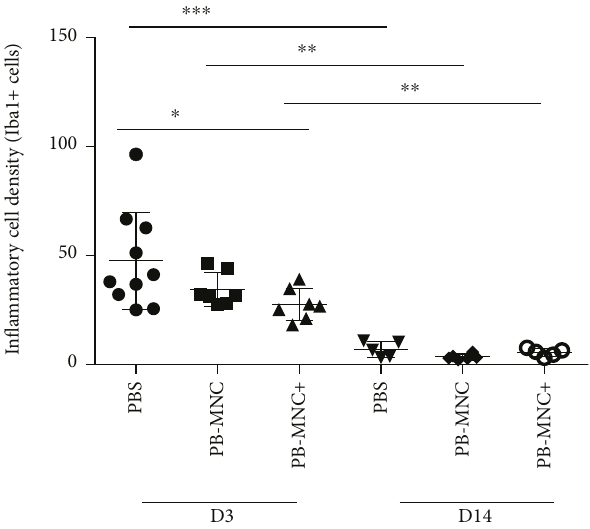
Figure 6: Microglia/macrophage cell density is decreased in mice treated with diabetic PB-MNC+. Iba-1 cell density was signi fi cantly decreased by ephrin-B2-stimulated PB-MNC compared to PBS at D3 ( N = 7 – 10 /group). By D14, microglia/ macrophage density had signi fi cantly decreased in 3 groups compared to D3 with no inter groups di ff erences ( N = 5 – 6 ). Data